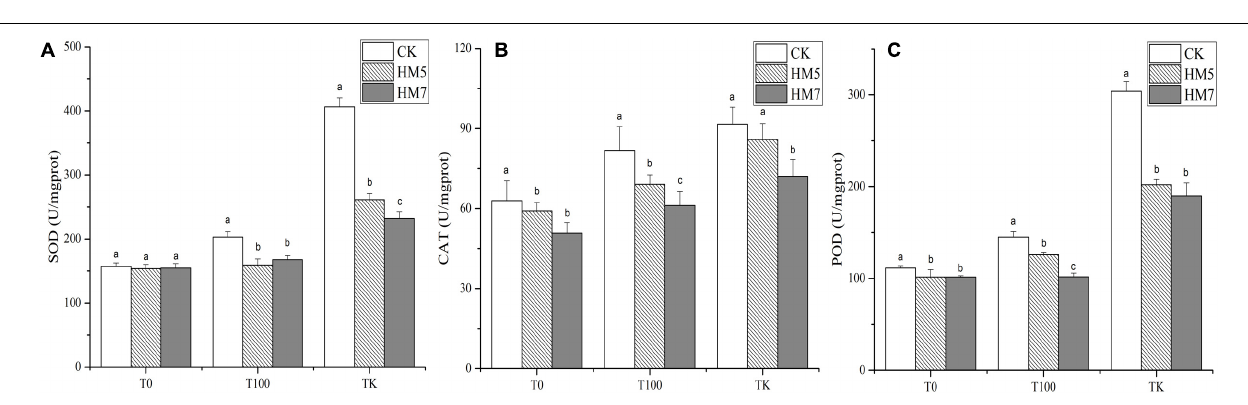
FIGURE 3 | The content of antioxidant enzyme activities in B. papyrifera . (A) The content of SOD. (B) The content of CAT. (C) The content of